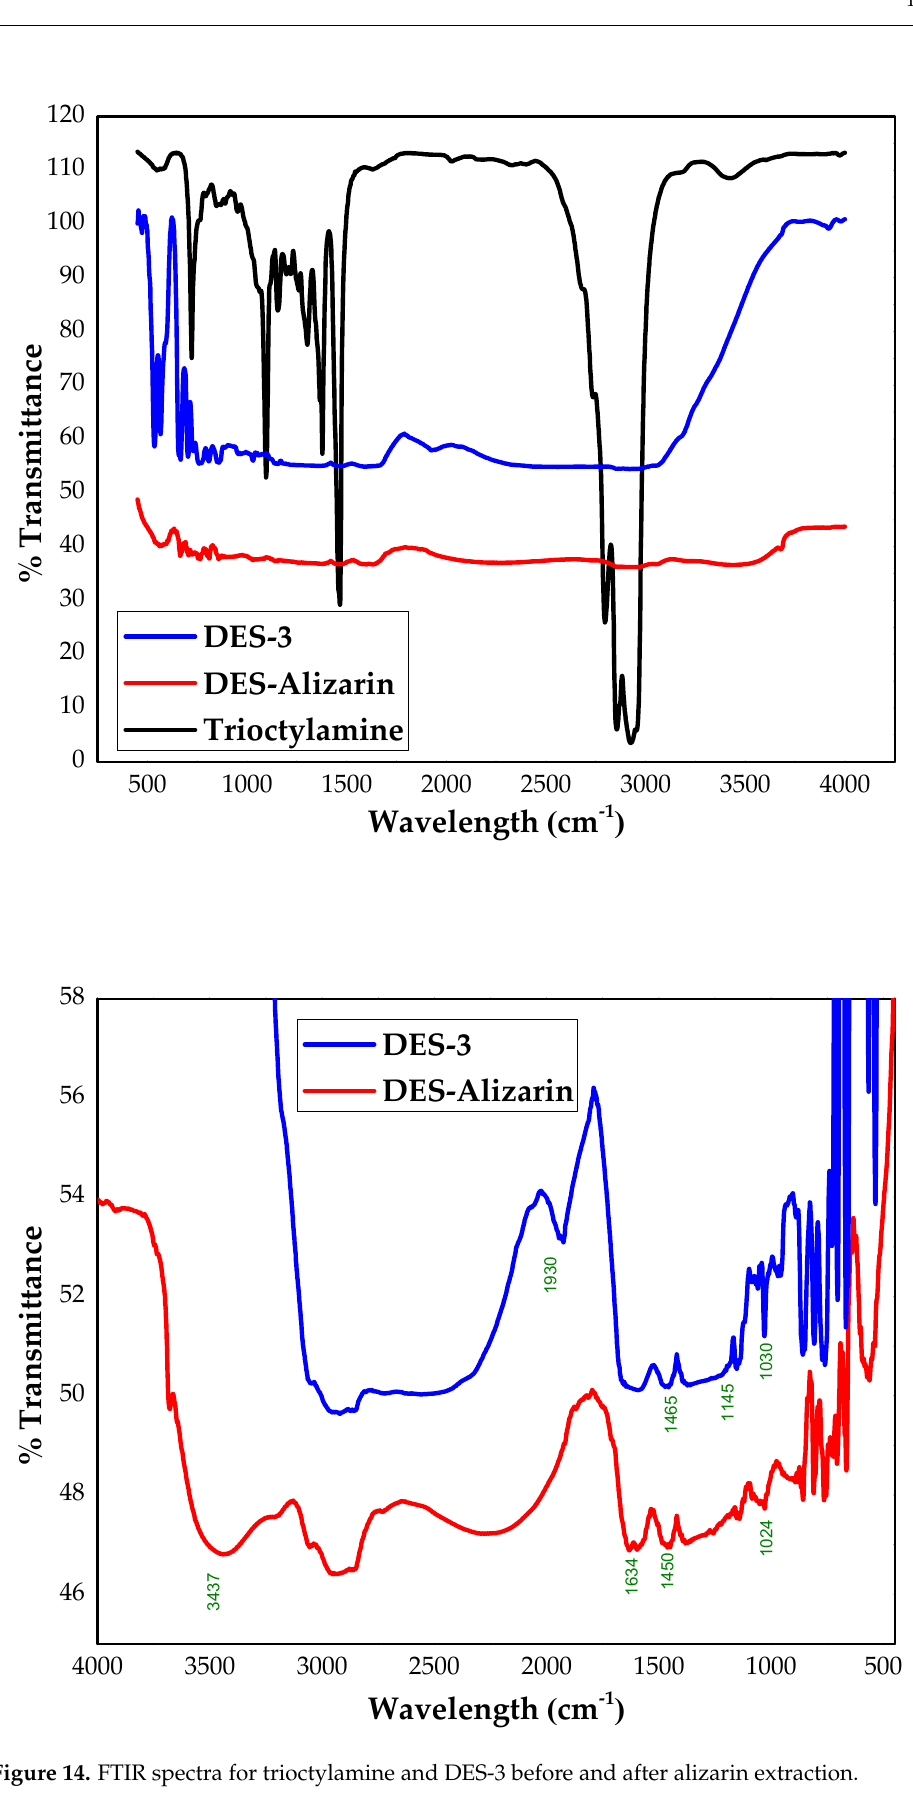
Figure 14. FTIR spectra for trioctylamine and DES-3 before and after alizarin extraction.